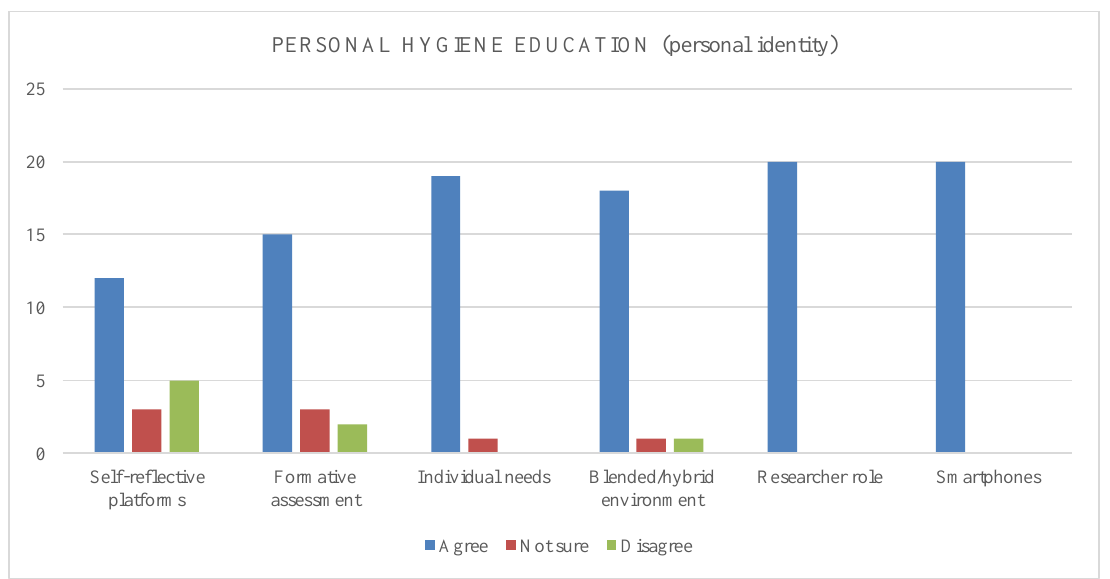
Figure 2: Personal hygiene